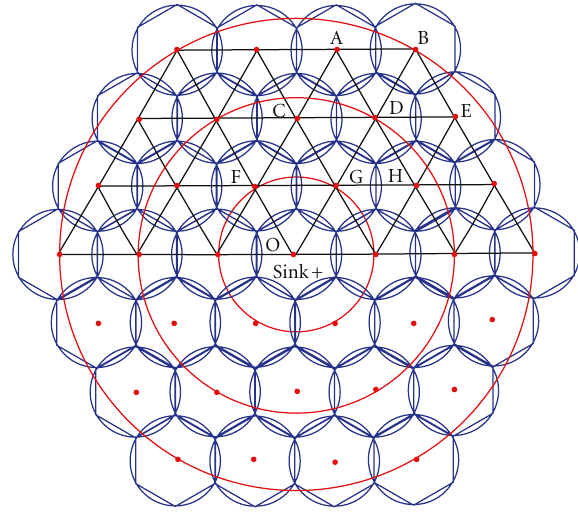
Figure 6: Inter-cluster multihop routing.